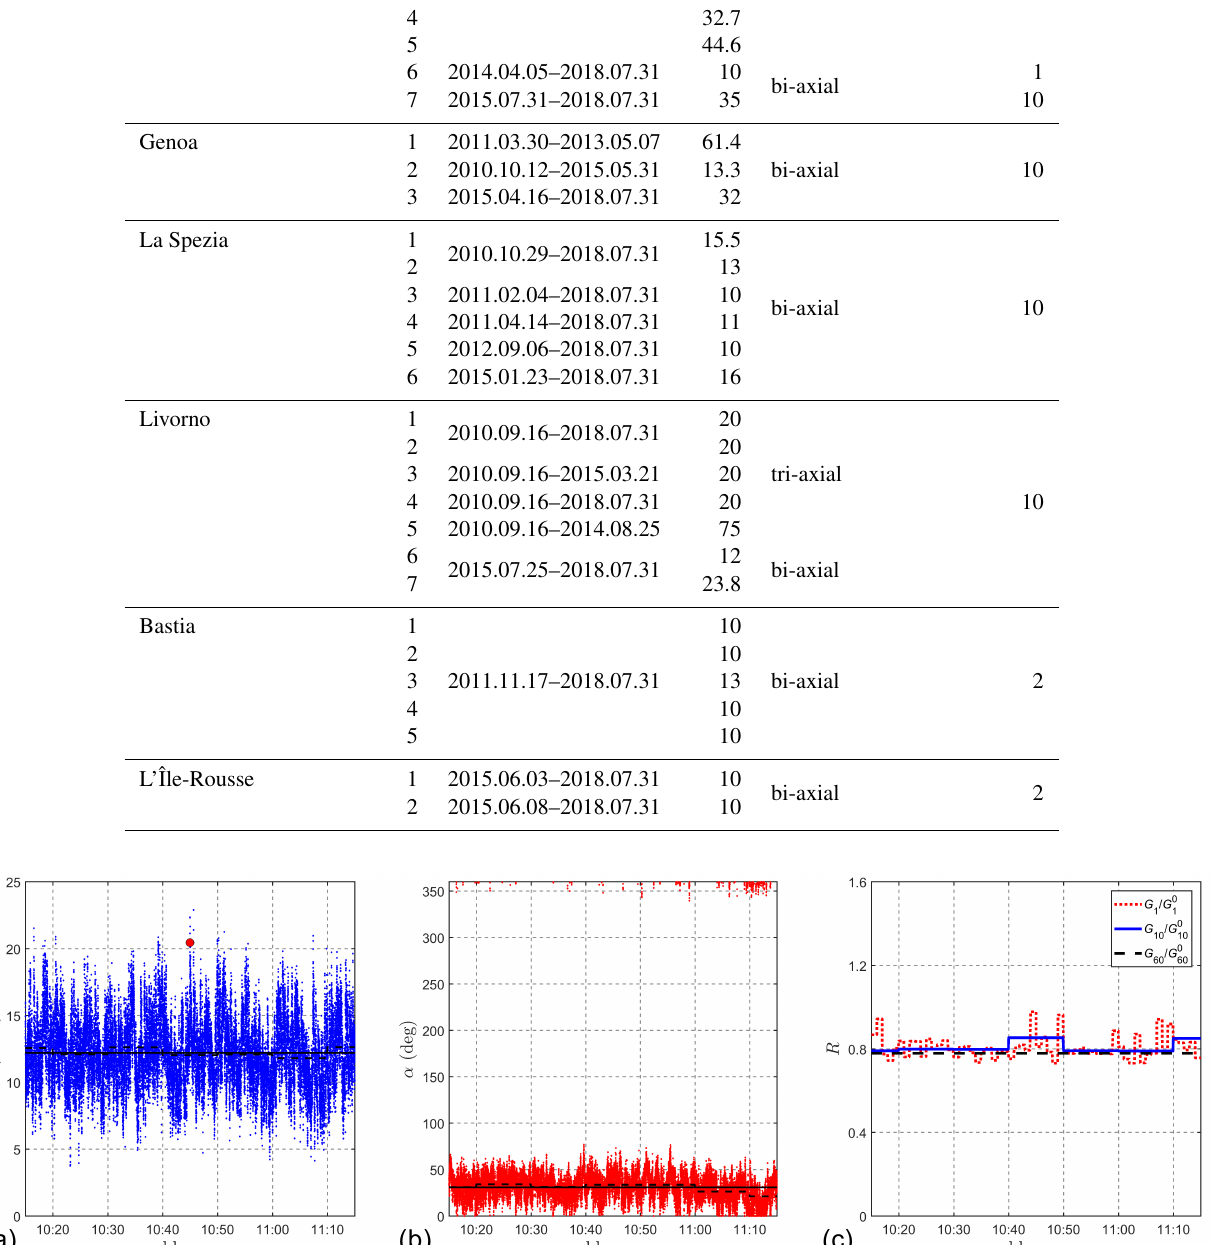
Figure 5. Extra-tropical cyclone recorded on 1 December 2013 by the anemometer 3 of the port of La Spezia: (a) 1h wind speed time-series; (b) wind direction time-series; and (c) ratio of gust